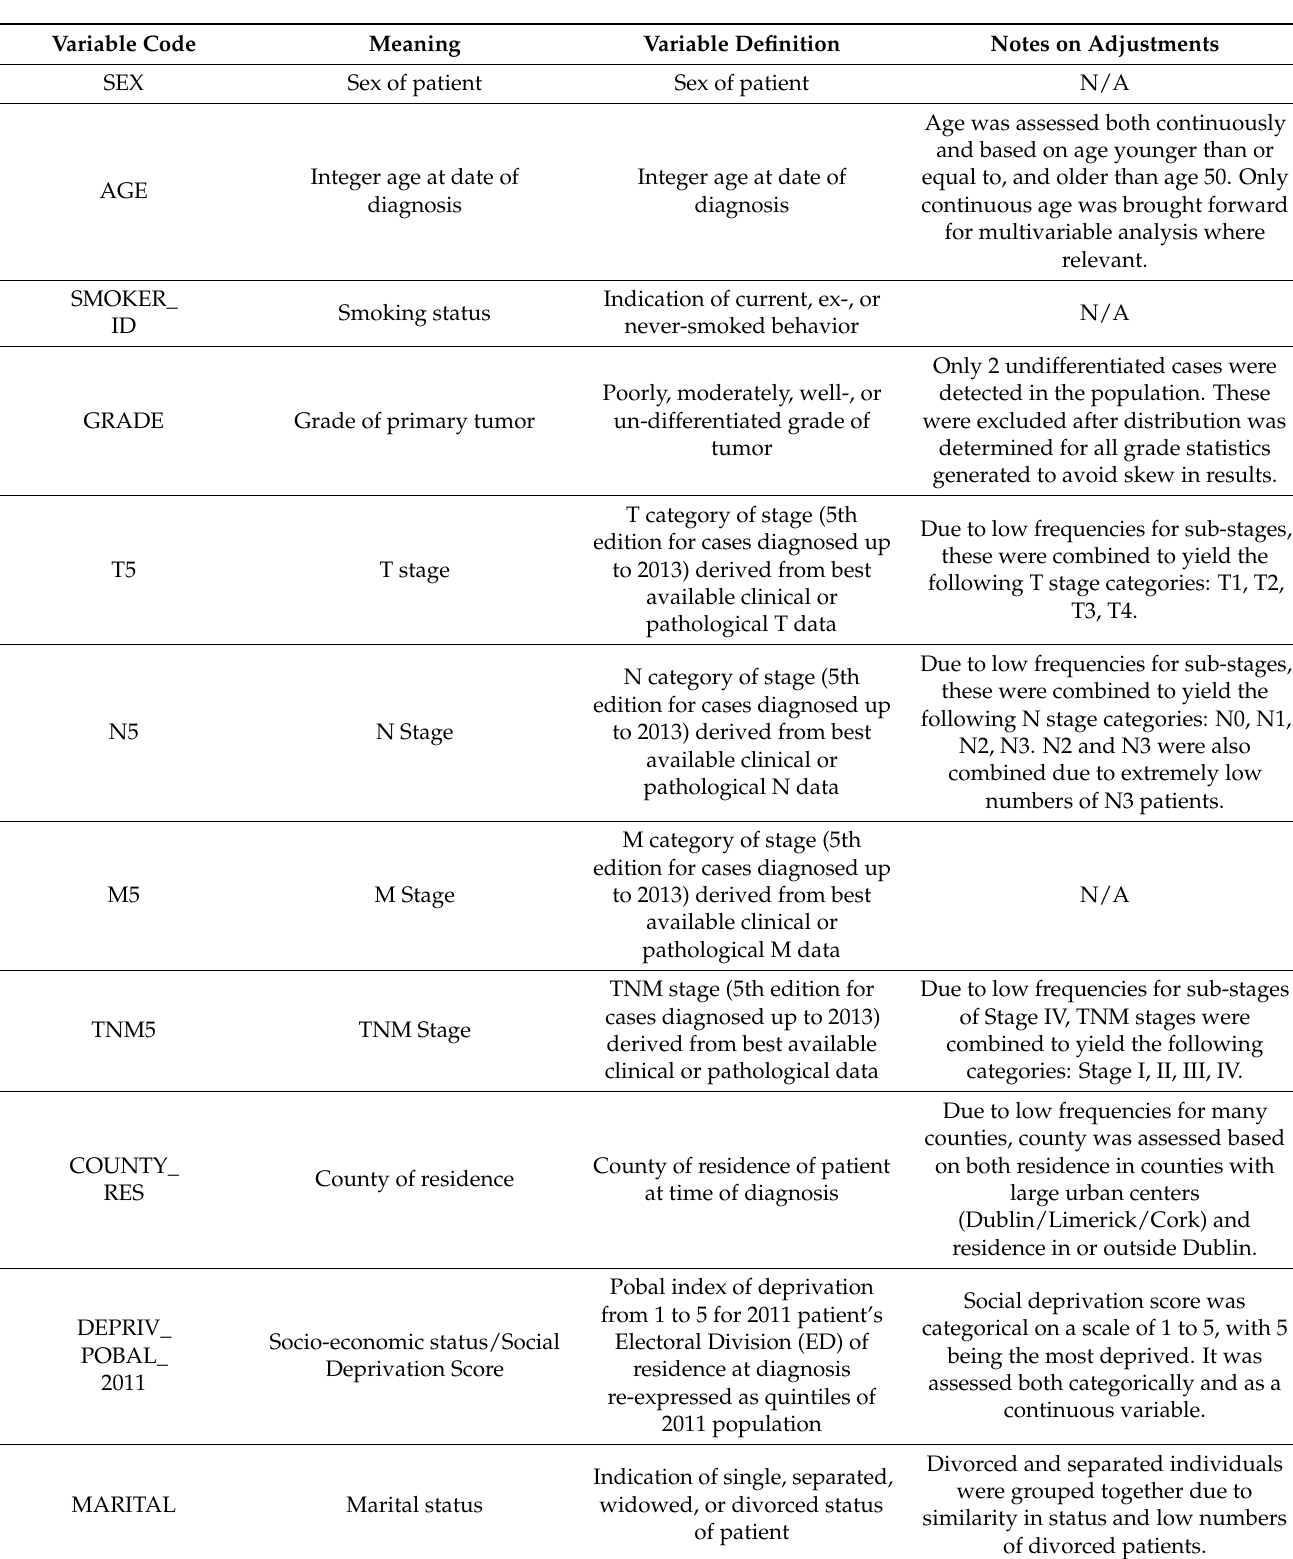
Table 1. Independent variables made available by the NCRI for the population of the study and notes on any adjustments made for the purposes of the